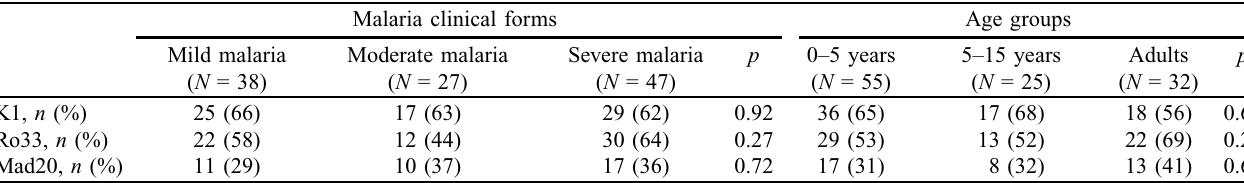
Table 2. Msp-1 allelic family distribution according to clinical status and